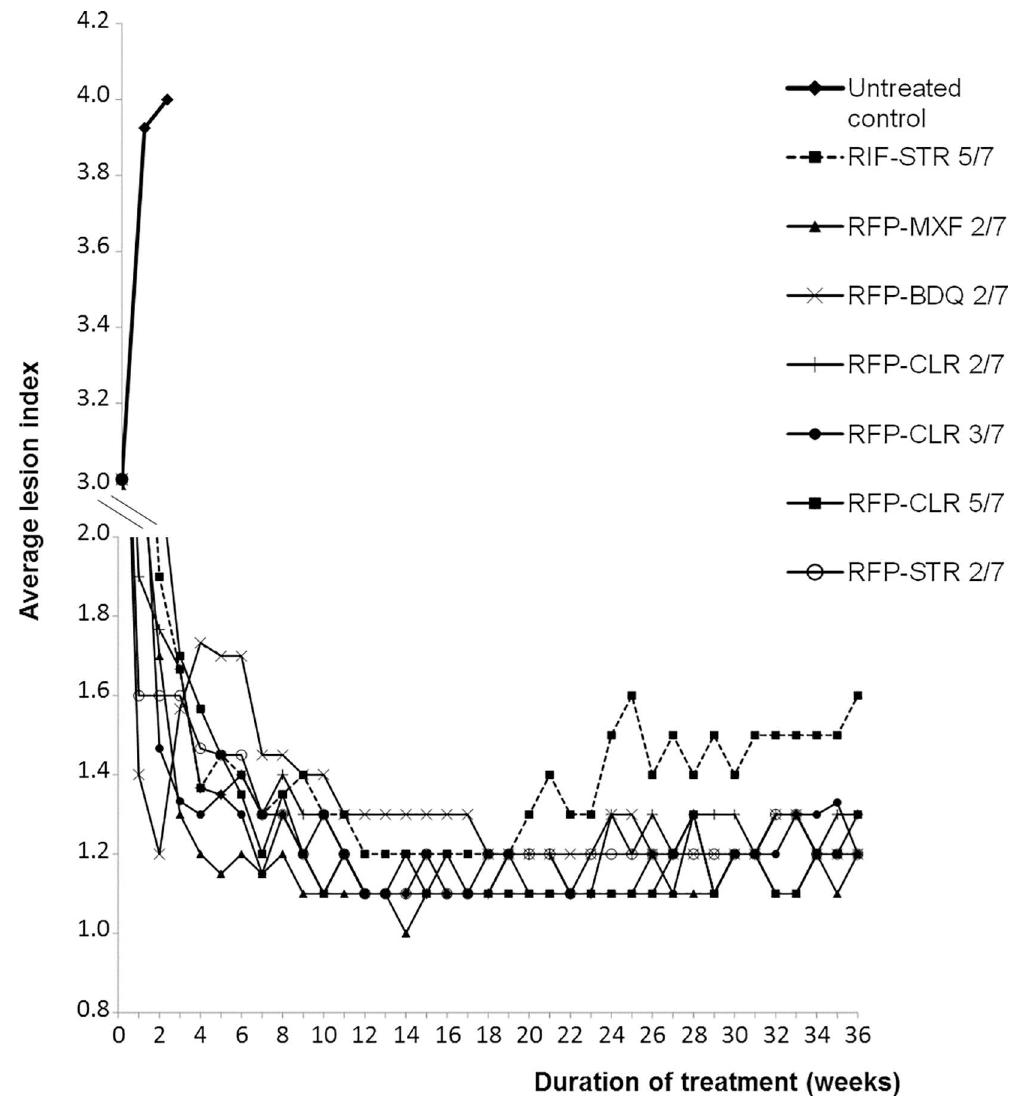
Fig 1. Evolution of the average lesion indexes in the control and treated